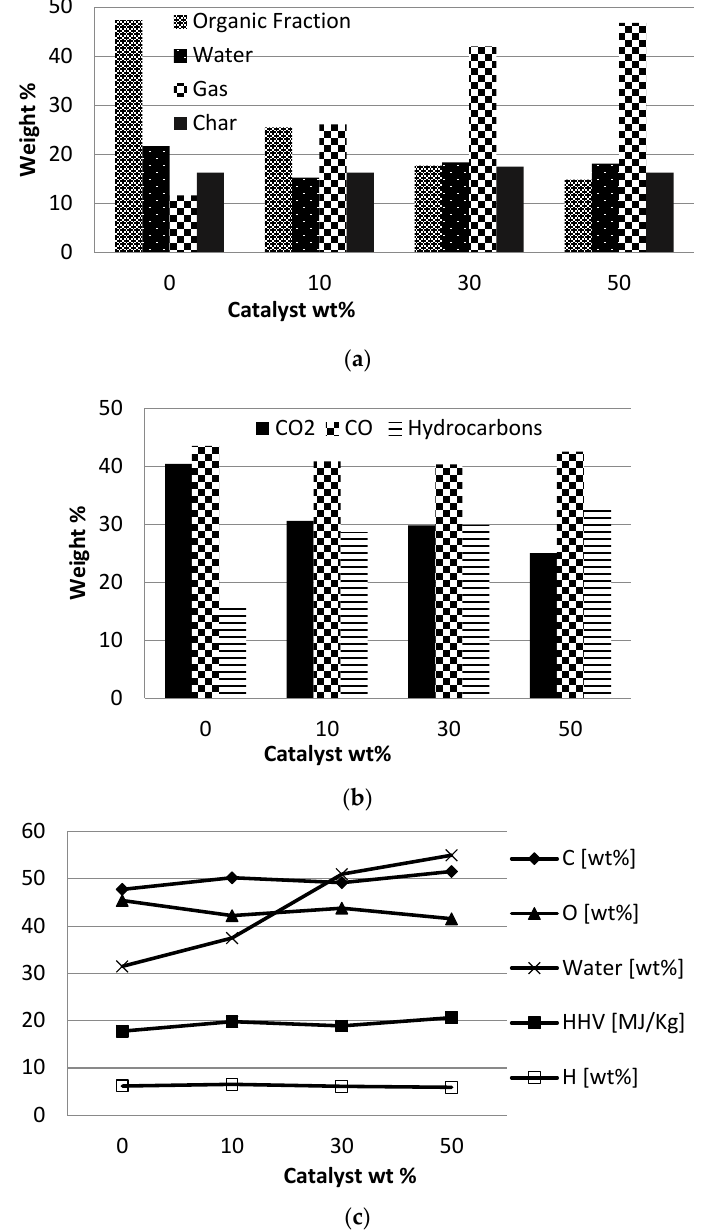
Figure 2. ( a ) Effect of the H-ZSM5/biomass ratio on pyrolysis products yields. ( b ) Effect of the H-ZSM5/biomass ratio on the gas composition. ( c ) Effect of the H-ZSM5/biomass ratio on the characteristics of the bio-oil.